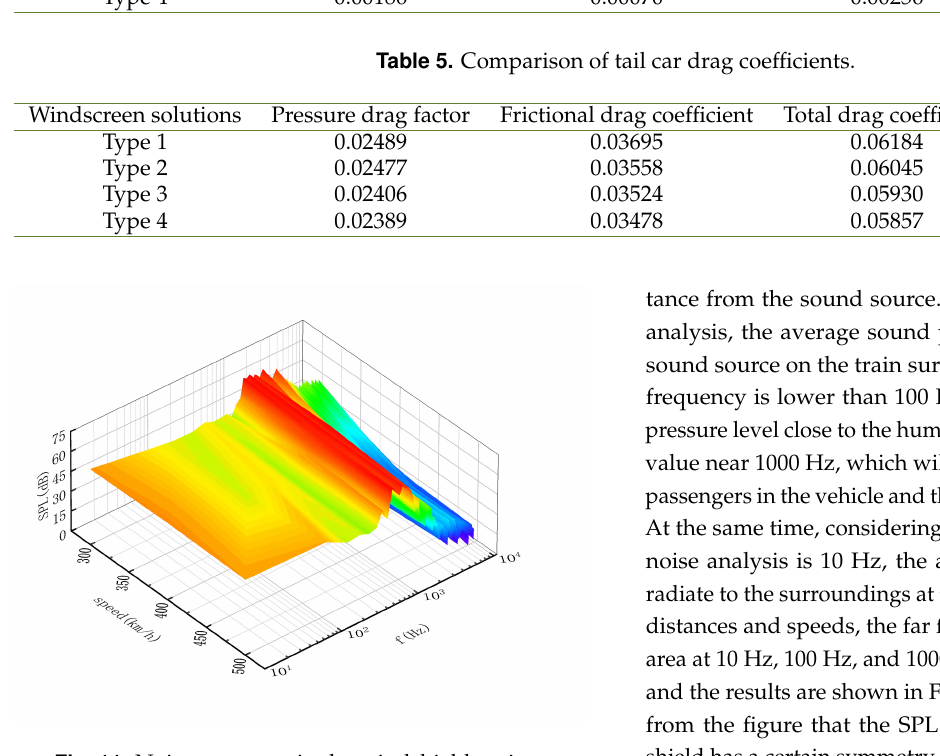
Fig. 11. Noise spectrum in the windshield region.